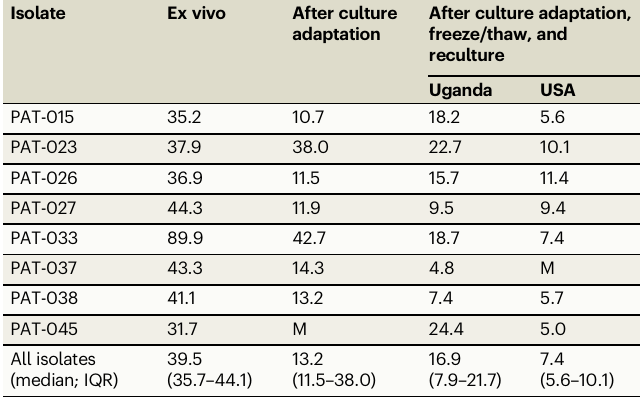
Table 5 | Lumefantrine susceptibilities before and after cul- ture adaptation Isolate Ex vivo After culture